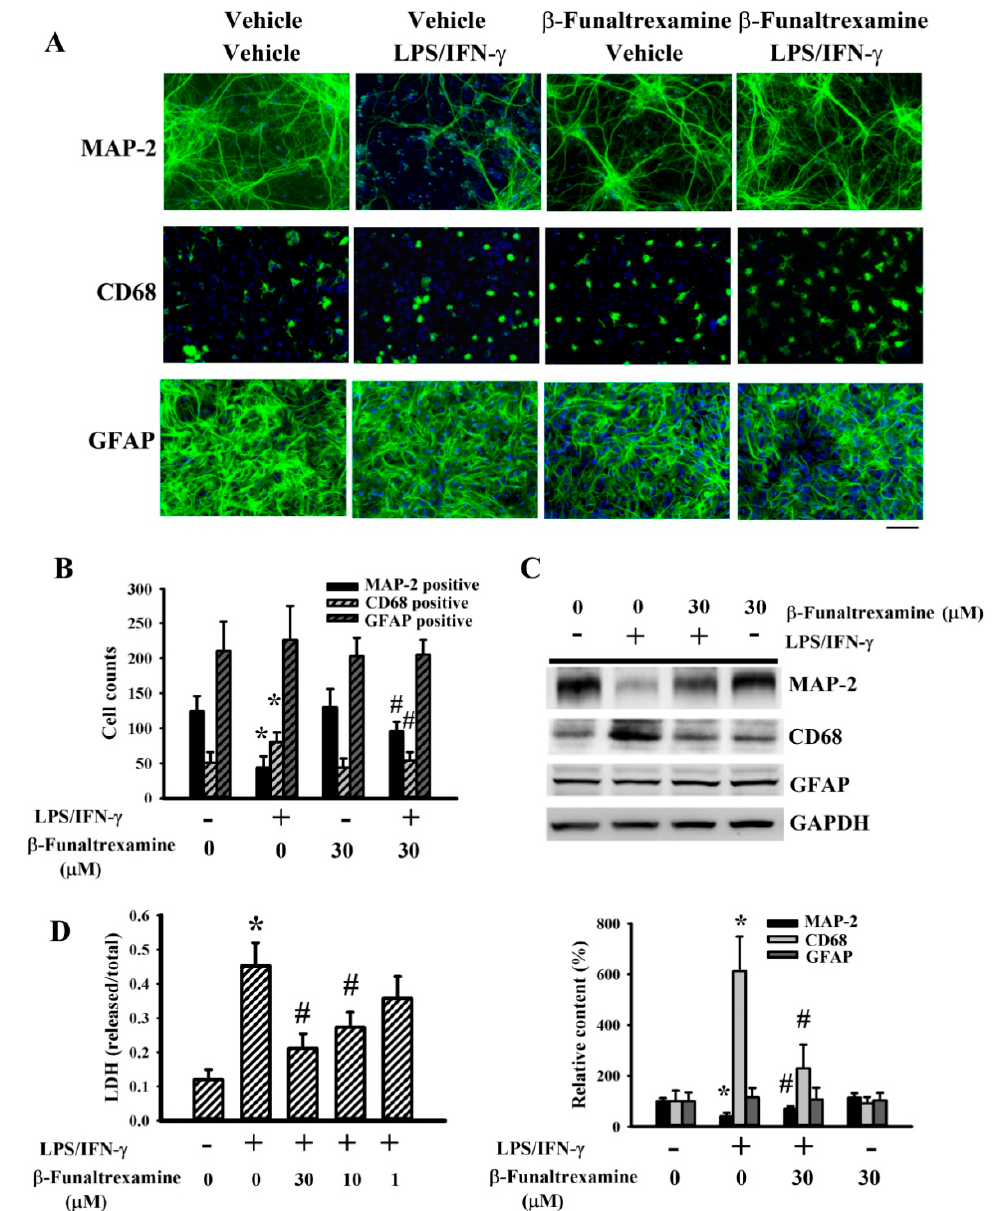
Figure 2. β -funaltrexamine alleviated neuronal cell death. Neuron / glia cultures were pretreated with vehicle or β -funaltrexamine (30 µ M) for 30 min before being incubated with LPS (100 ng / mL) / IFN- γ (10 U / mL) for an additional 48 h. Cells were subjected to immunofluorescence staining with antibodies recognizing Microtubule-Associated Protein 2 (MAP-2), CD68, and Glial Fibrillary Acidic Protein (GFAP). The cell nuclei were counterstained with Hoechst 33342. Representative micrographs are shown. Bar = 60 µ m ( A ). Quantitative numbers of immunopositivity are shown ( B ). Total cellular proteins were extracted and subjected to Western blot analysis with indicated antibodies. One representative blot of four independent culture batches is shown ( C ). Cell damage was measured by LDH e ffl ux assay ( D ). * p < 0.05 vs. untreated control and # p < 0.05 vs. LPS / IFN- γ control, n = 4.